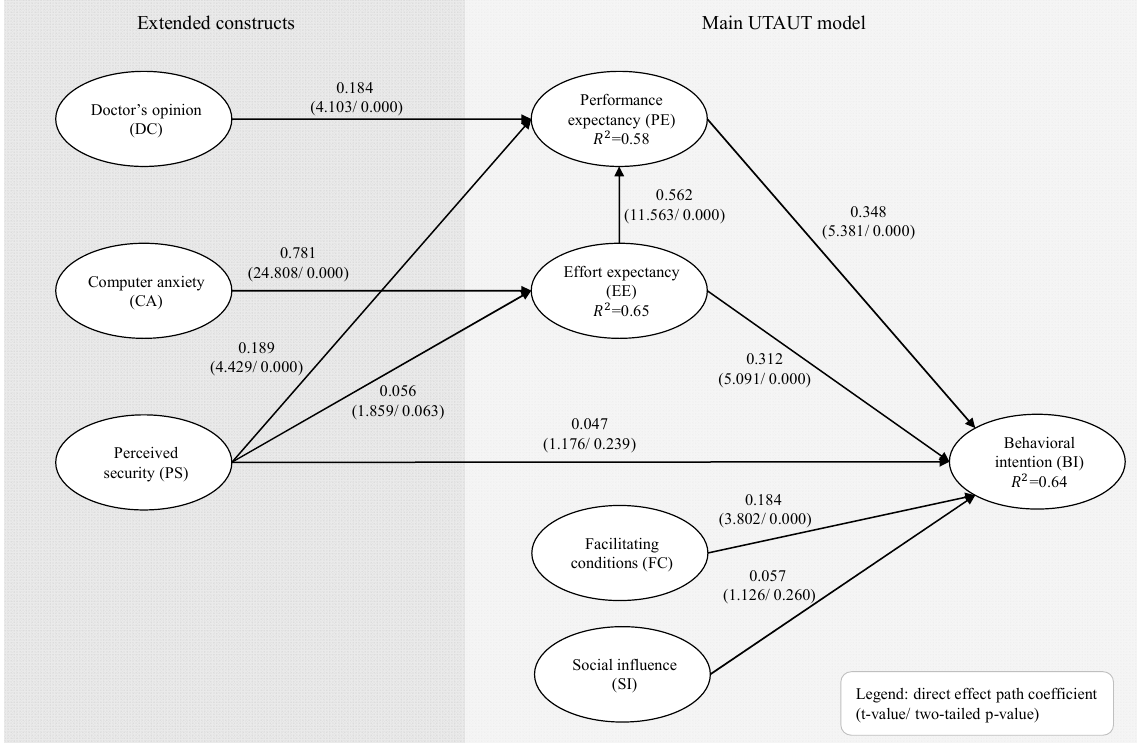
Figure 1. Estimated path model with direct effects (t-values/ p -values).